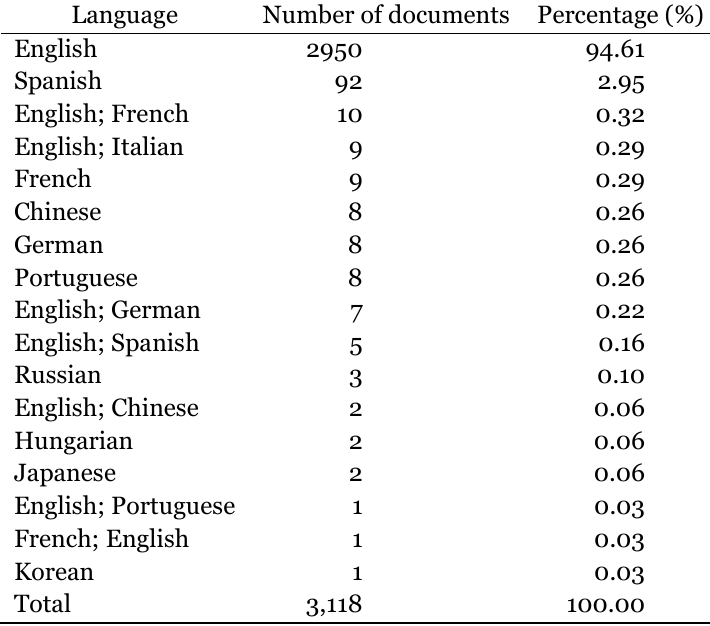
Languages Used for MOOCs Research